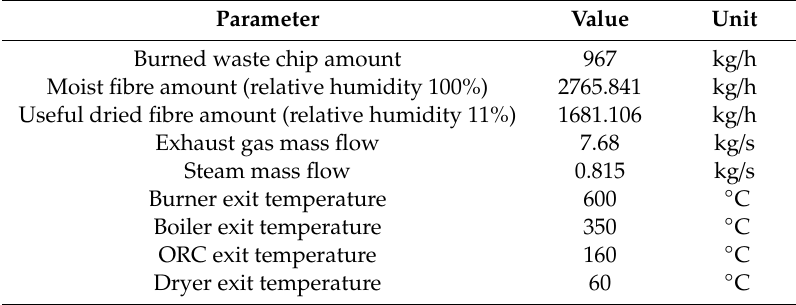
Table 1. The additional design and parametric optimisation assumptions for the ORC.